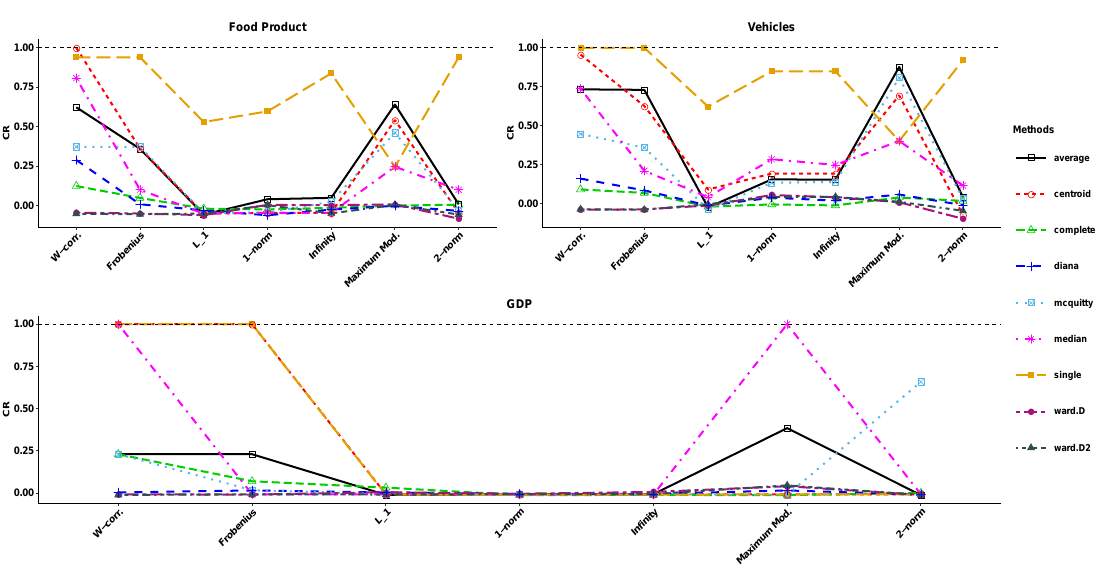
Figure 10. The CR index for the real-world time